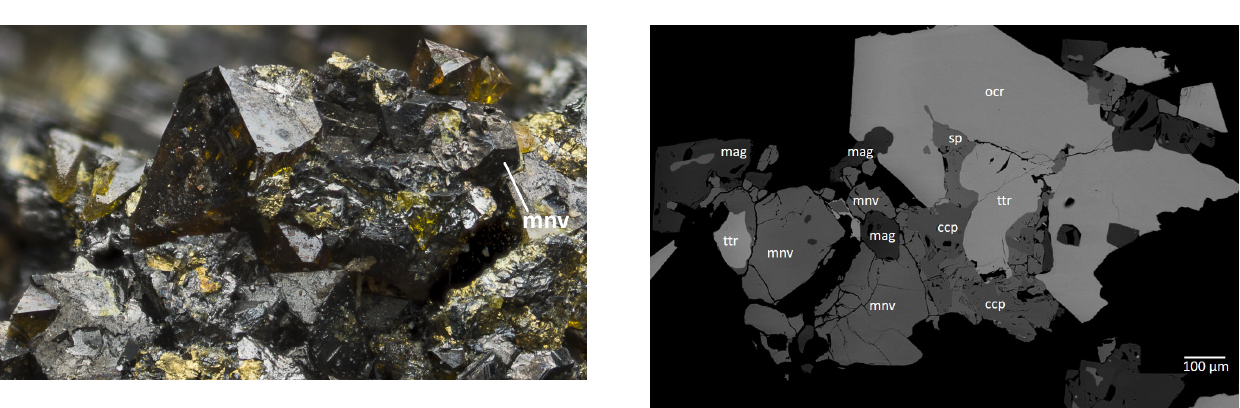
Figure 1. Macroscopic photograph of monteneveite (mnv) in the holotype specimen, GEO-NRM catalogue no. HS3903, here seen together with almost euhedral, honey-yellow crystals of oxycal- cioroméite and associated minerals. Field of view is 2.5mm. © Lorin. All rights reserved.